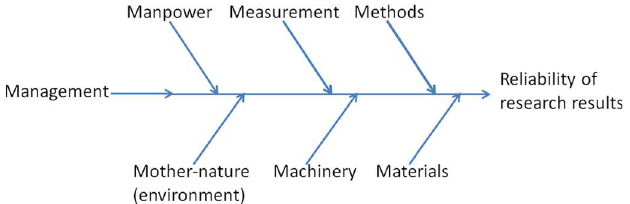
Fig. 2. Ishikawa ‘Fishbone’ diagram (principle of